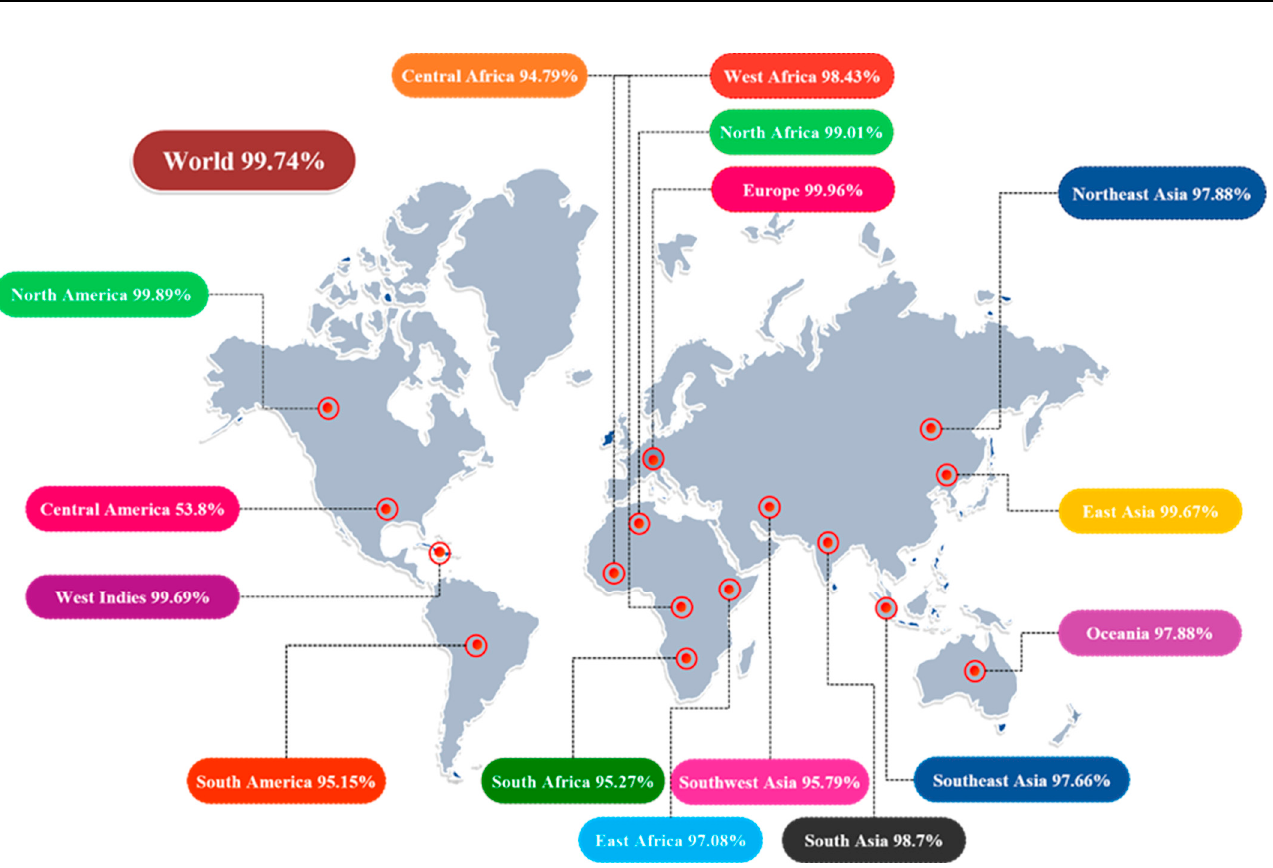
Figure 3. Illustration of immune-dominant, finalized B-cell-derived T-cell epitopes with global pop- ulation coverage.